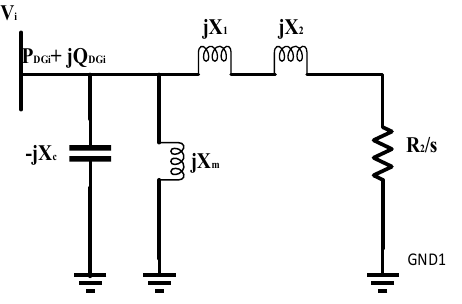
Figure 3. Equivalent circuit of synchronous generator.